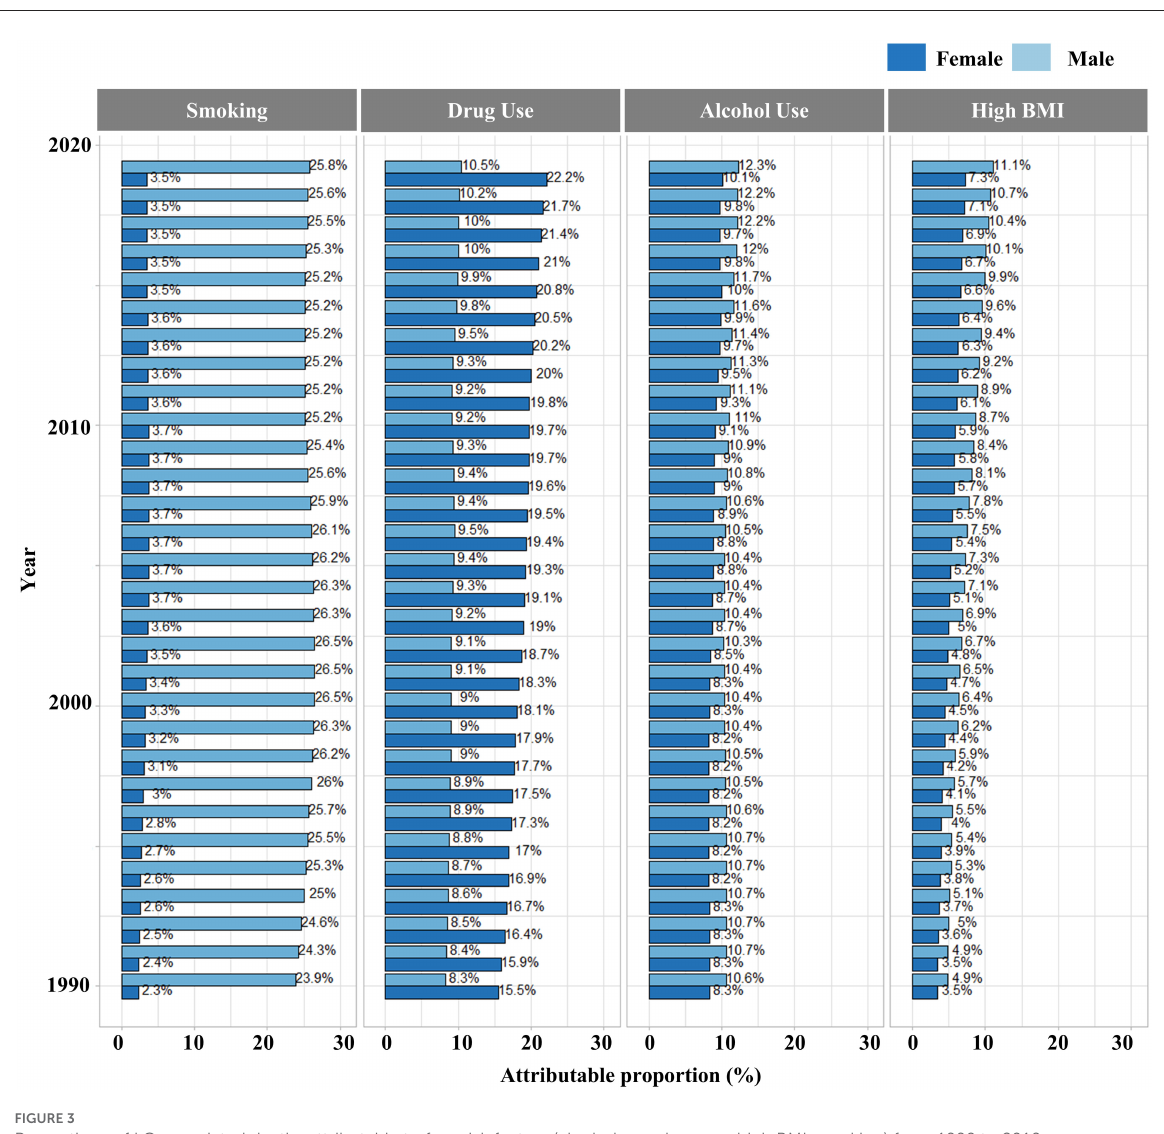
gender difference between HCV-associated and HBV-associated LC because the incidence and mortality of HCV-associated LC were higher in females but that of HBV-associated LC were higher in males ( >